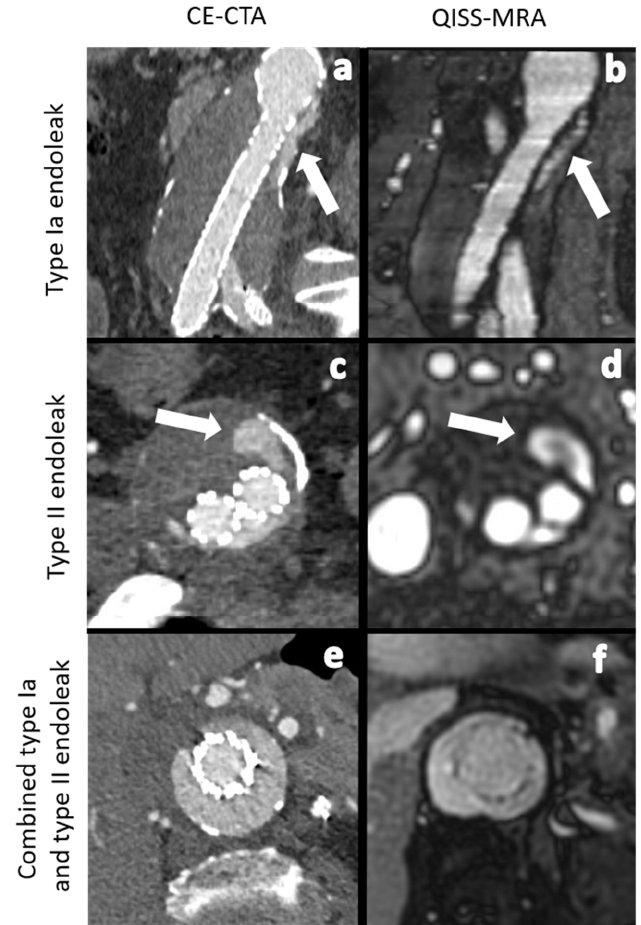
Figure 1. Comparison between CE ‐ CTA ( left ) and 2D non ‐ CE radial QISS ‐ MRA ( right ) concerning the detection of various endoleak types. The white arrows indicate a type Ia endoleak in images ( a , b ) and a type II endoleak in images ( c , d ). In images ( e , f ) CT ‐ and QISS ‐ MRA studies of a patient with a combined type Ia and type II endoleak can be seen.